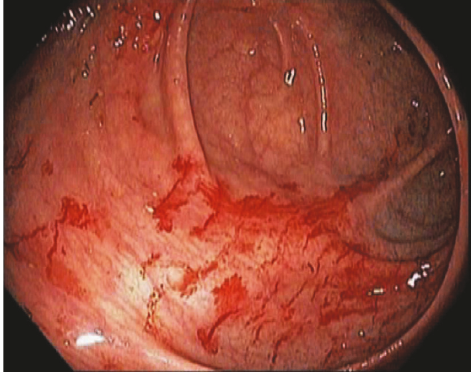
Figure 8: Endoscopic image of mucosal findings of barotrauma in the cecum.